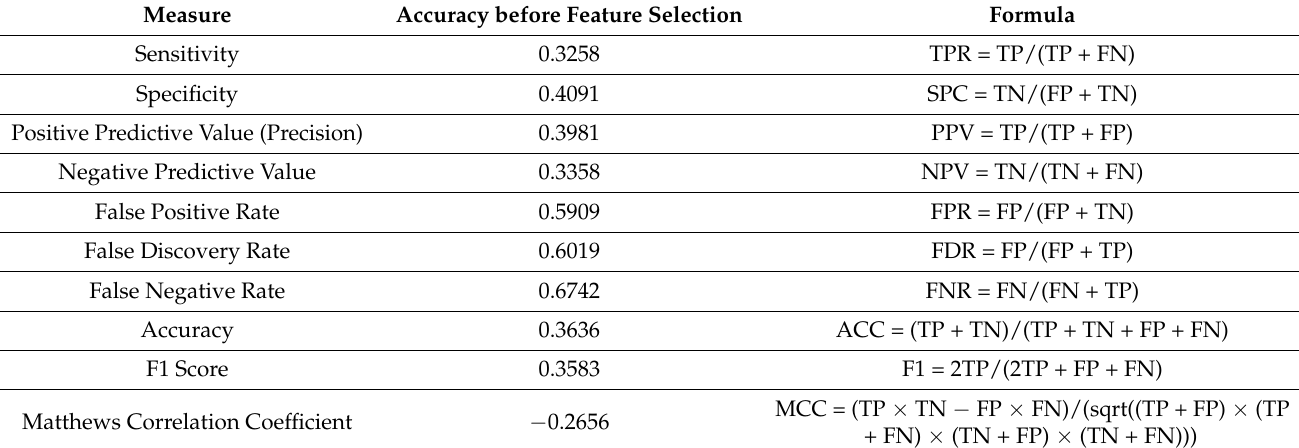
Table 4. Multi-model evaluation